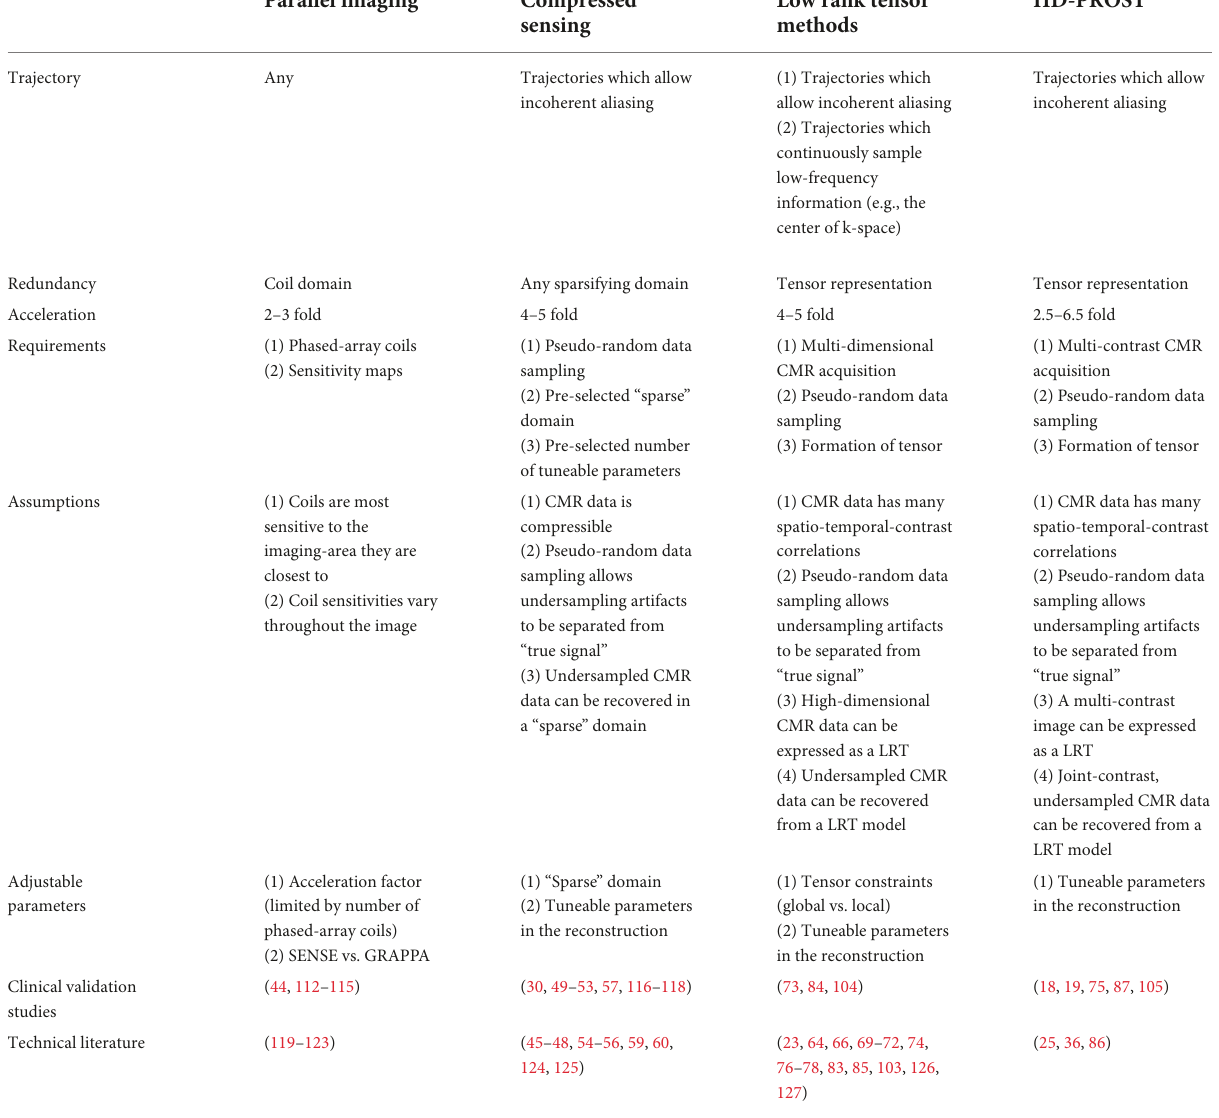
TABLE 1 Comparison of acquisition and reconstruction properties of sparse sampling techniques discussed in this